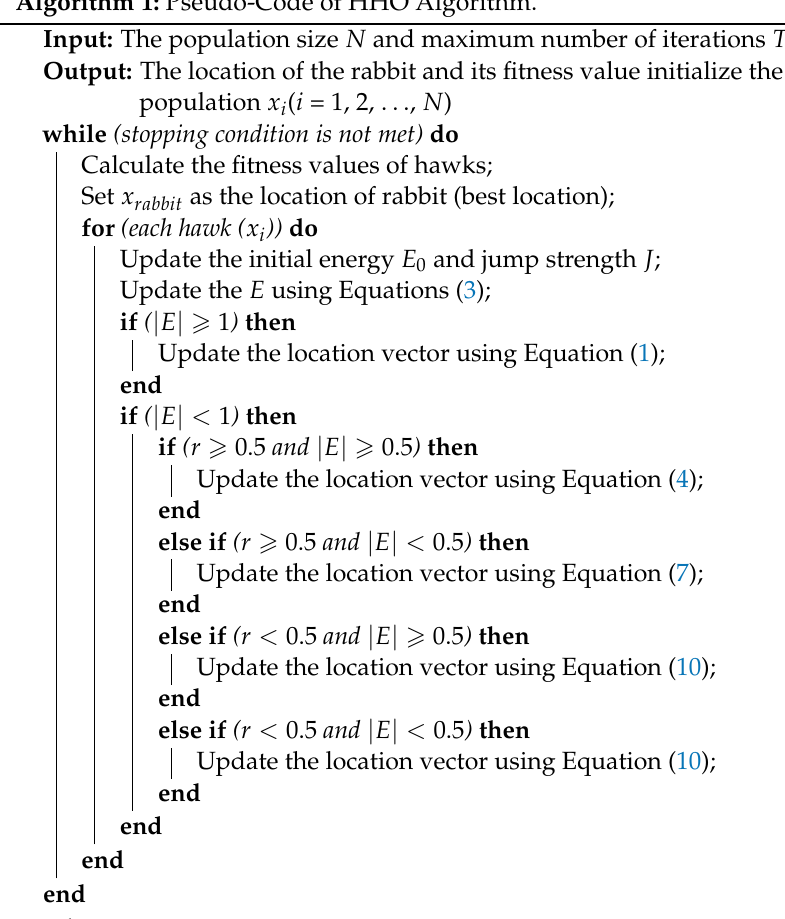
Algorithm 1: Pseudo-Code of HHO